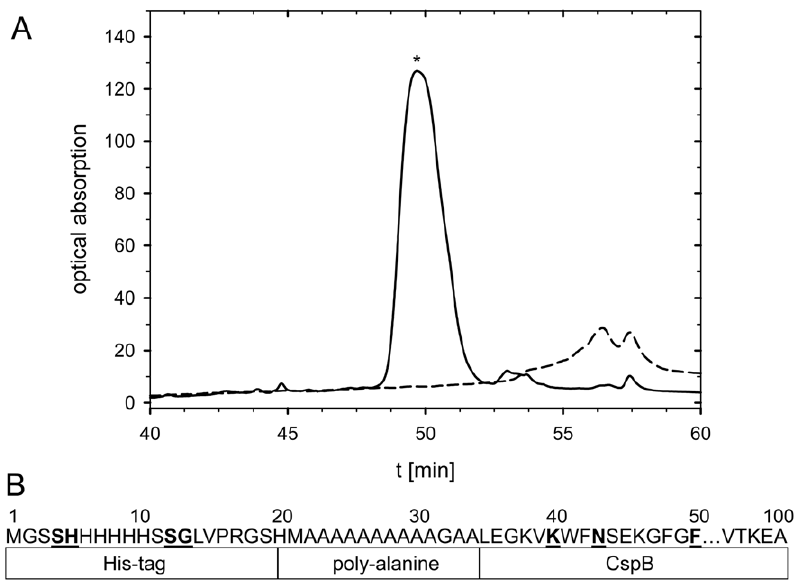
Figure 2. Determination of the fibrillar core of the ‘‘direct fusions’’. A RP-HPLC chromatograms of intact and protease digested solubilized fibrils of 10Ala-CspB. Intact fibrils, dashed line; proteinase K digested fibrils, solid line. The chromatograms were recorded by UV absorption at a wavelength of 210 nm. The peaks were collected and analyzed by mass spectrometry. B Schematic representation of the proteolysis protected amino acid sequence of the fibrils of 10Ala-CspB. The underlined and bold amino acids represent the beginning and the end of the protected segments.